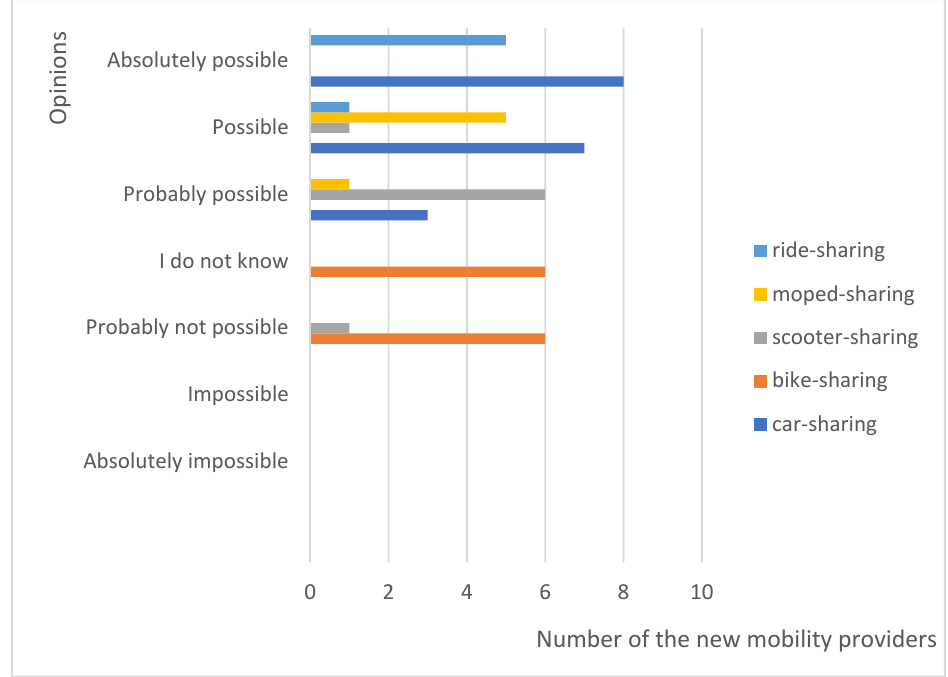
Figure 9. The possibility of the implemented practices remaining implemented in the new mobility market after the pandemic.